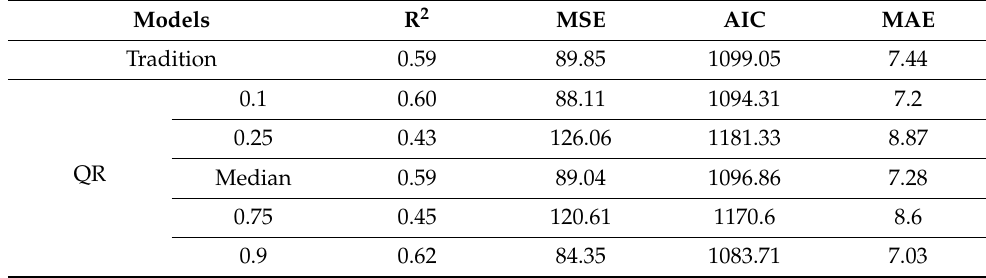
Table 8. Model fitting and testing